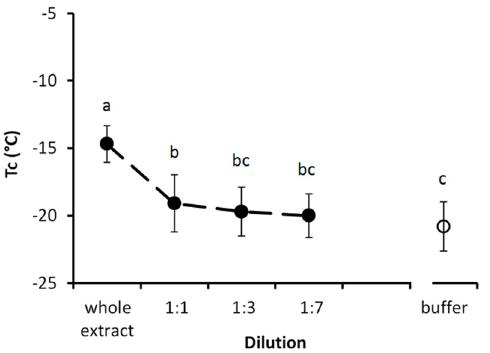
Fig 8. Ice nucleation activity in S . feltiae in comparison with buffer control (25 mM Tris, pH 8). Error bars are ± standard deviations, N = 24. Different small letters above the error bars represent that treatments are significantly different ( P <